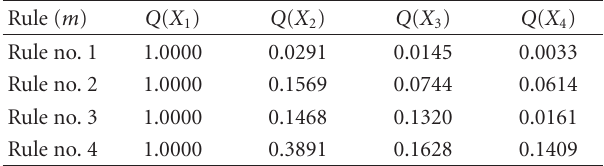
Table 17: Estimated Q -measures.